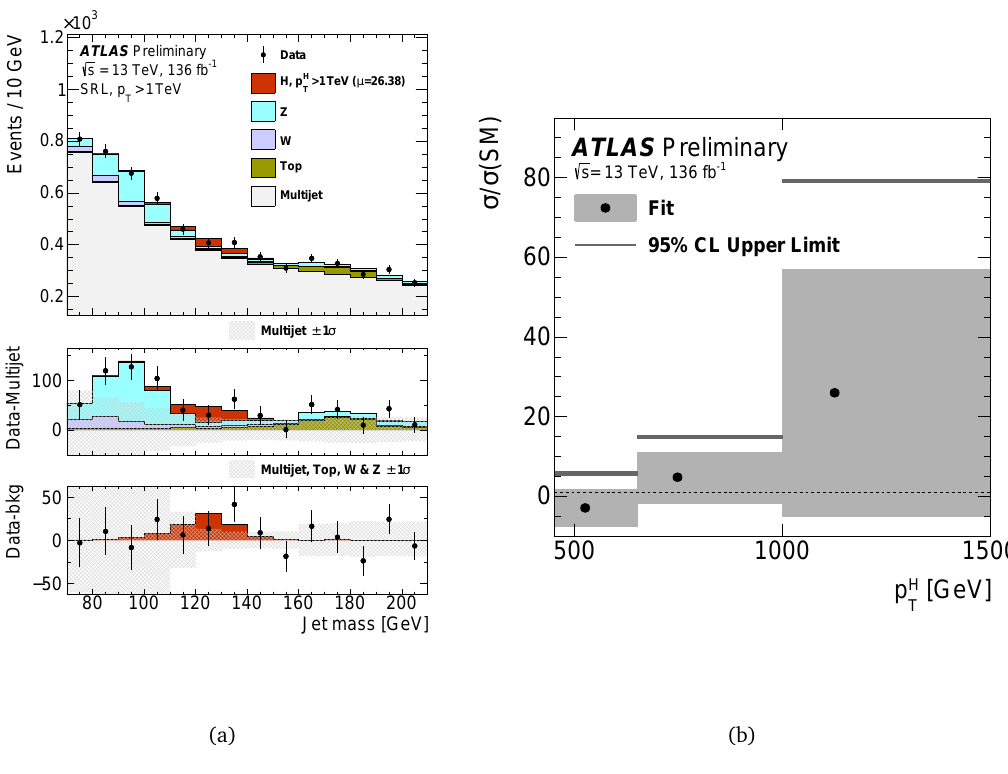
Figure 2: (a) Jet-mass distribution in the signal region where the highest- p > 1 TeV has two b -tagged sub-jets [ 14 ] . The top panel shows the R jet with p T original mass distribution, while the middle (bottom) panel is the distribution where the multi-jet (both multi-jet and resonant) background is subtracted. (b) Results from the p H -dependent cross section measurement [ 14 ] T